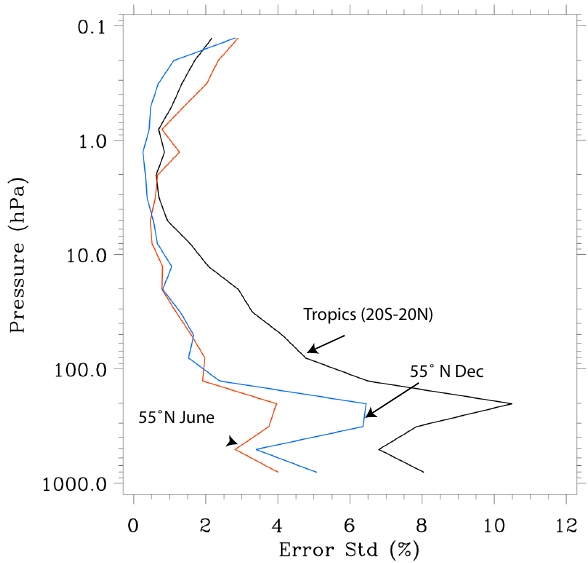
Fig. 11. Smoothing error (1 σ) in estimating MZM of layer ozone. Larger errors in the tropical lower stratosphere are caused by smaller layer DFS and larger year-to-year fractional variability due to QBO. The errors shown are typically the largest source of error in estimating MZM O 3 anomalies from an SBUV instrument.